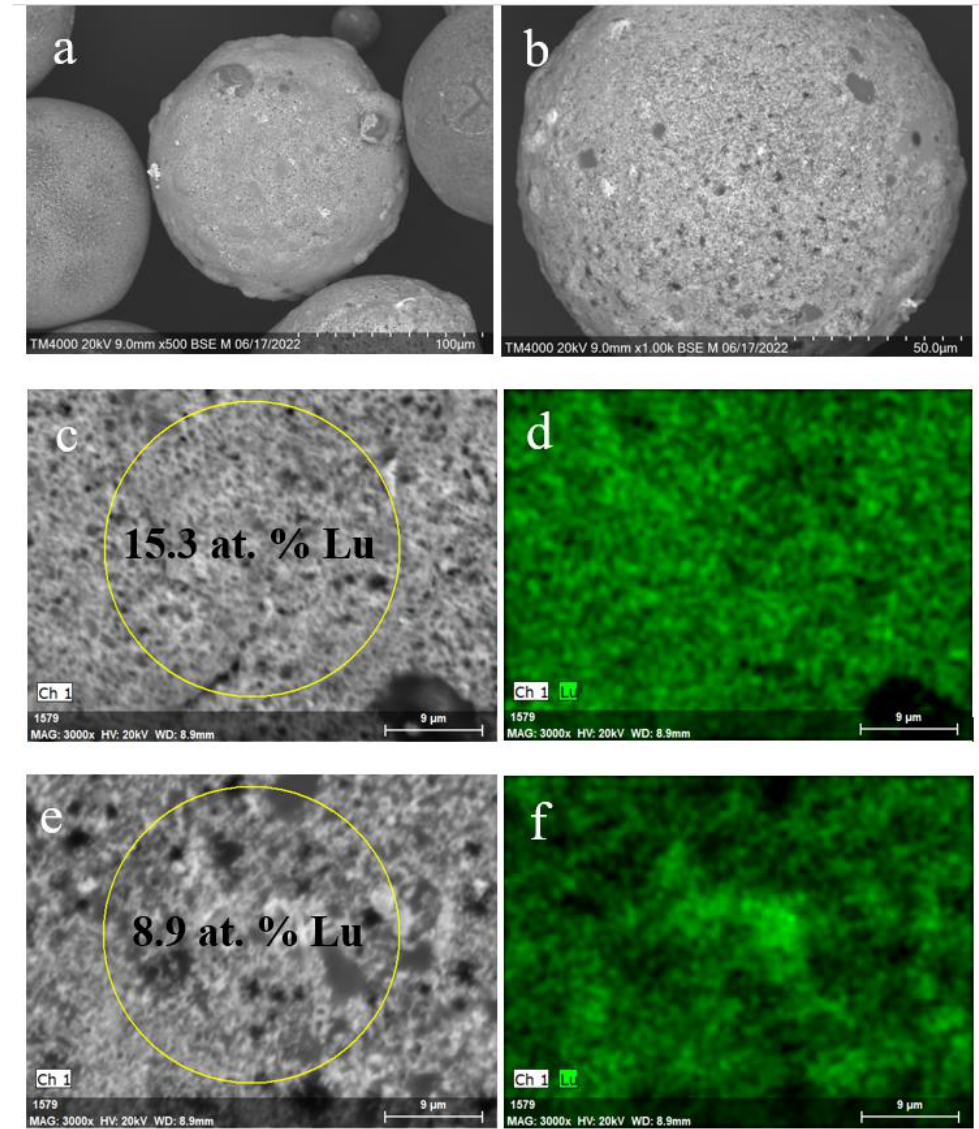
Figure 10. SEM images of the Lu 3+ loaded NaP1 microspheres ( a , b ) and local parts of the microsphere external surface ( c , e ) after thermal treatment at 1473 K; Lu distribution maps ( d , f ) for the local parts ( c , e ) of the microspheres ( d , f ).